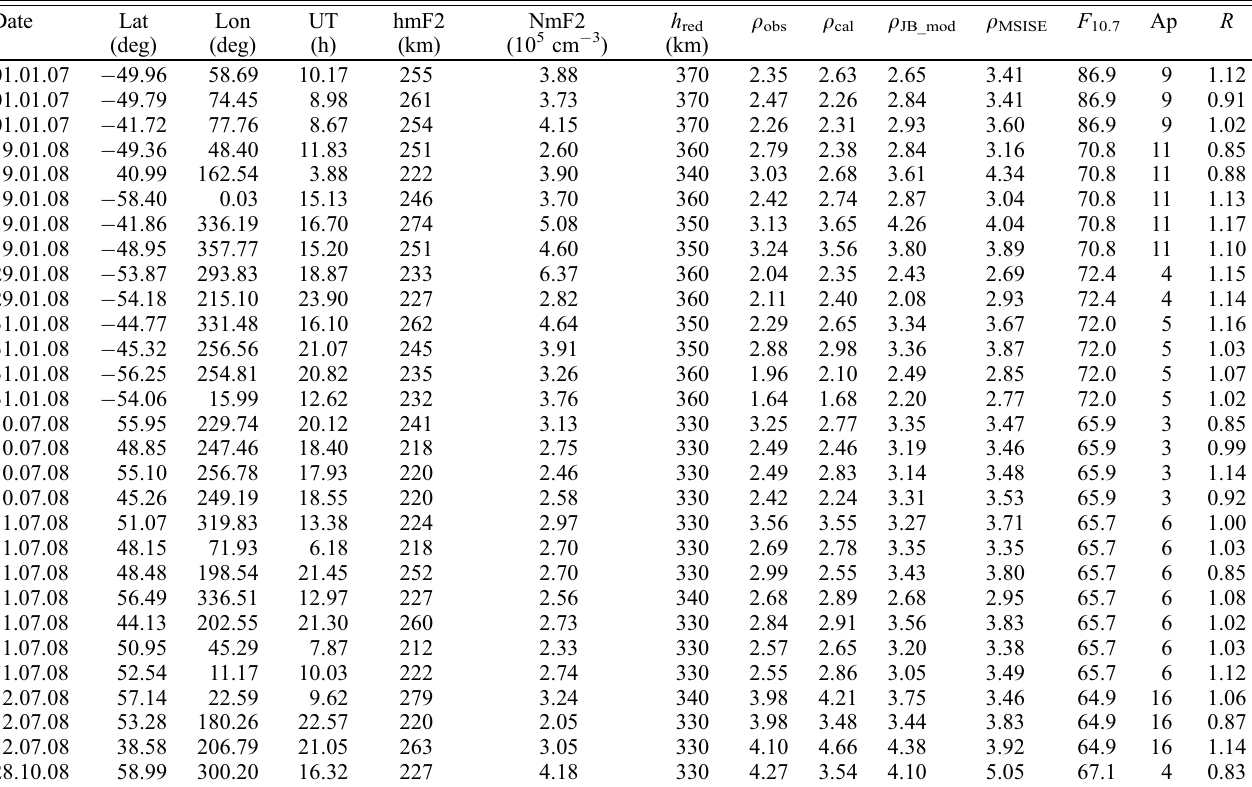
Table A1. Dates, coordinates and UT of the occultations observed under solar minimum for which solutions were within the R ave ± SD range are given along with the observed F2-layer maximum parameters. Observed and reduced to the heights h red neutral gas densities (10 (cid:2) 15 g cm (cid:2) 3 ) are shown in a comparison with the calculated and model values. Daily F 10.7 and Ap indices as well as relative deviations ( q cal / q obs ) are given in the last three